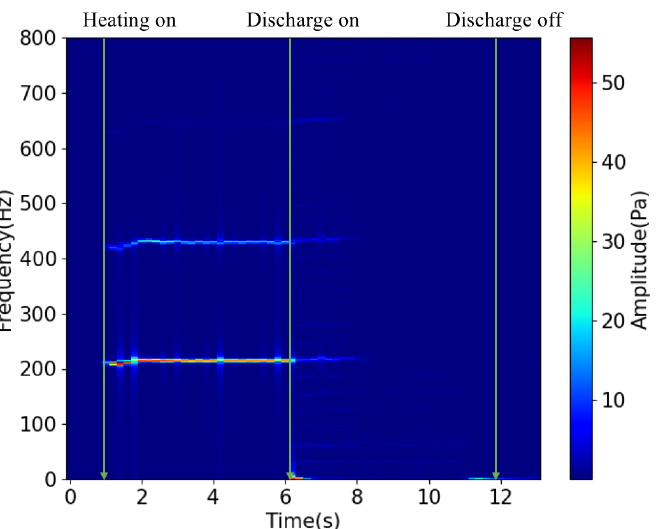
Figure 11. STFT results of the pressure signal in Figure 7e (5000 Hz discharge at 1.44 kW heating